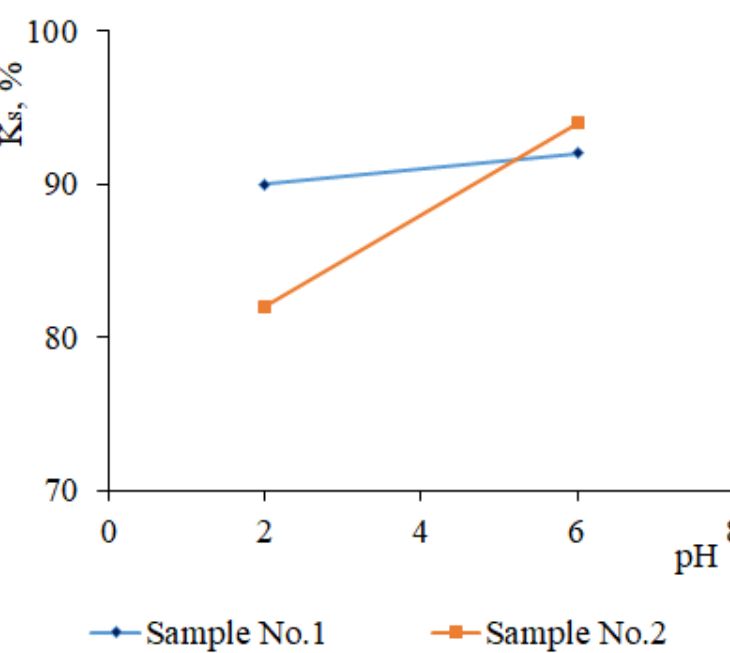
Fig. 4. Kineticsorption of ions Pb 2+ model samples of enterosorbents at different pH